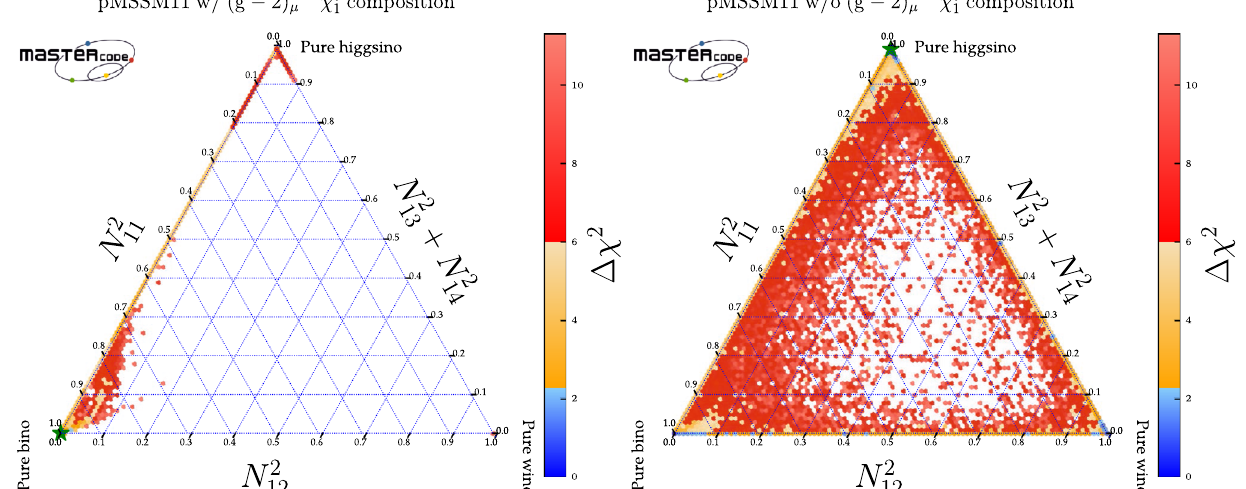
Fig. 13 Triangular presentations of the composition of the ˜ χ 0 (right) panel